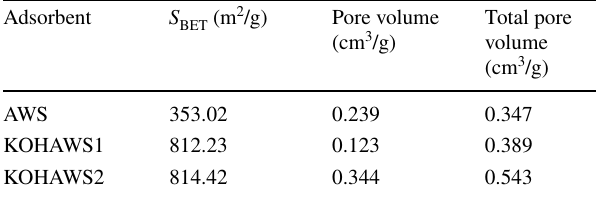
Table 2 BET Surface are analysis before and after activation